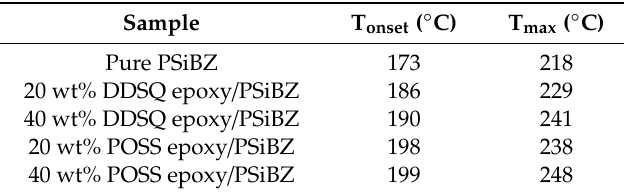
◦ Table 3. The storage modulus of pure PSiBZ was 960 MPa at 25 C. After 20 and 40 wt% DDSQ epoxy was added, the storage modulus increased to 1506 and 1516 MPa, respectively. In the 40 wt% POSS epoxy / PSiBZ, a higher storage modulus of 1753 MPa was obtained. The increases were approximately 158% and 183% for DDSQ and POSS, respectively, indicating superior reinforcement with